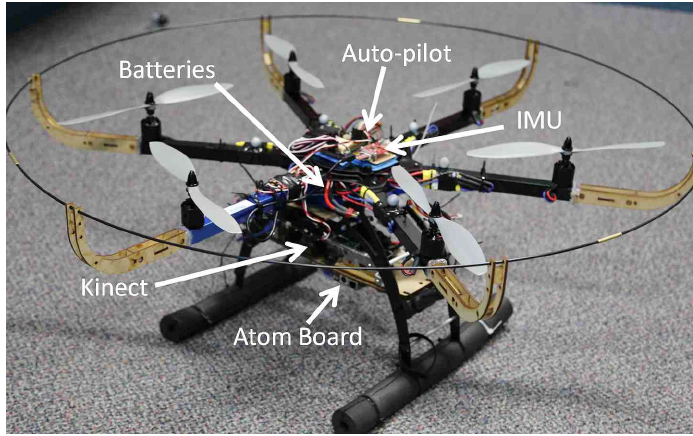
Figure 4. A hexacopter platform equipped with Kinect/IMU sensors and an Atom processor. To verify the method, 900 Kinect frames and 1501 IMU data packets were collected from an indoor environment. To simulate the depth dropouts, some of the depth data were discarded to verify the proposed approach. The estimated pose from the proposed method was compared against the ground truth data from Vicon, as shown in Figure 5. The trajectory shows the take-off and lateral movements of the hexacopter platform, and the dropouts are shown in a rectangular box. The errors were computed using the ground truth in terms of root-mean-square error (RMSE). Table 1 summarizes the performance showing that the RMSE is less than 0.2 m and 0.5 ◦ , and there is an improved performance closely resembling the ground truth. Figure 6 also confirms the consistency of the system, showing a visibly consistent 3D map after the pose-graph SLAM optimization.